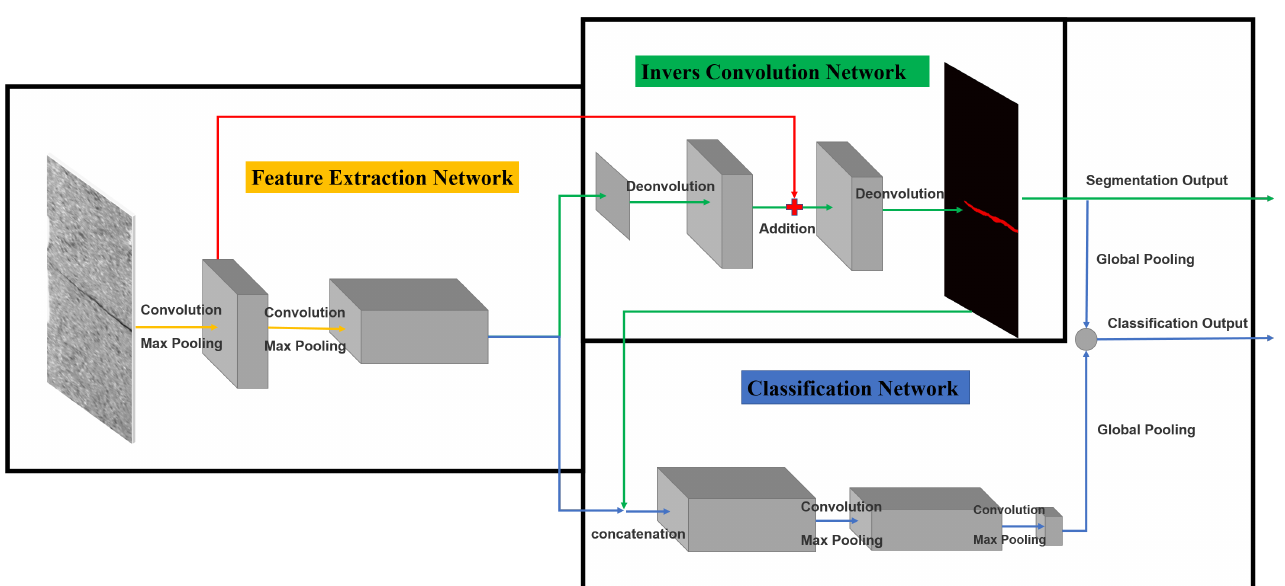
Figure 2. Simplified structure of